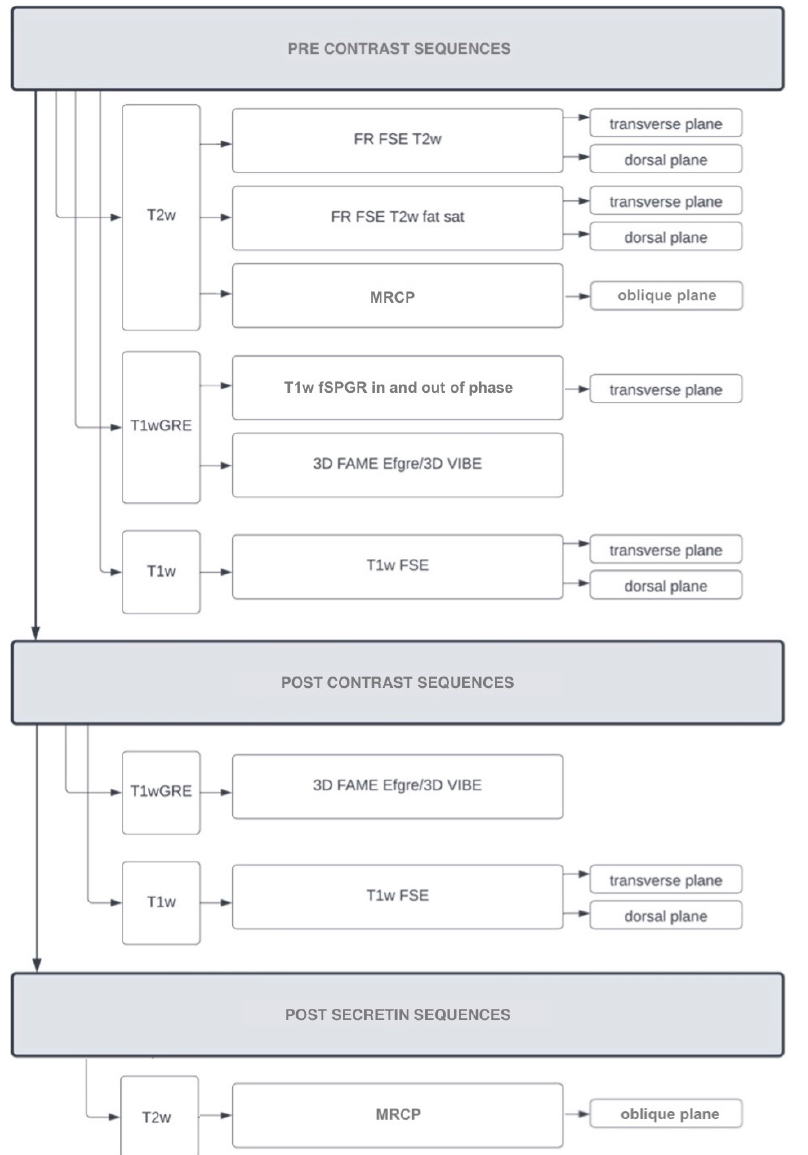
Figure 1. MRI and MRCP proposed protocol for canine and feline patients, including pre-contrast sequence, post-contrast sequences and post-secretin sequence.